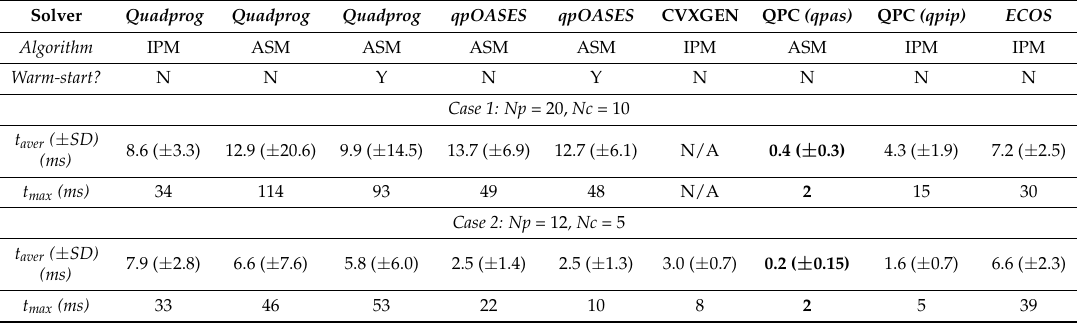
Solver runtime performance computed for 4000 time points; t aver , t max and SD (standard deviation) are the average, the maximum and the standard deviation of the solver runtime in ms observed over the duration of the experiment; IPM (interior point method) and ASM (active-set method) are the interior point method and the active-set method, respectively, and Y/N indicate the inclusion or not of the warm-start procedure. In detail, the examined solvers are Quadprog (quadratic programming) of Matllab, qpOASES (quadratic programming online active set strategy), CVXGEN (code generator for embedded convex optimization), QPC (quadratic programming in C) using either qpas (quadratic programming active set) or qpip (quadratic programming interior point) and ECOS (embedded conic optimization